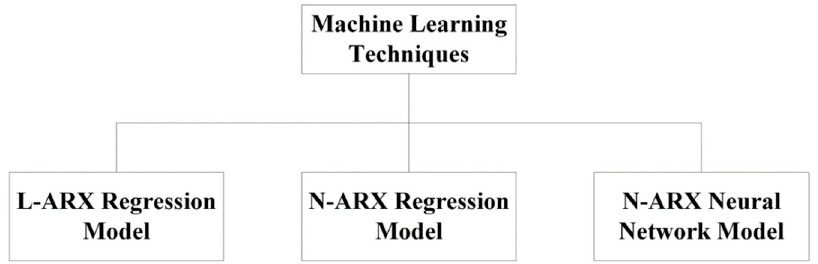
Figure 8. Machine learning methods used in the study.